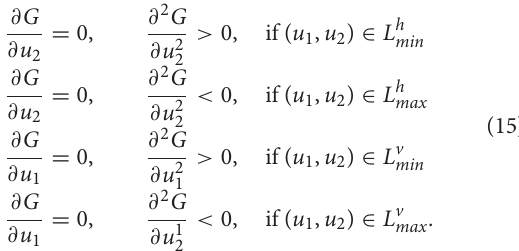
S a . Note that the largest value of R corresponds to the points of i the submanifolds S a